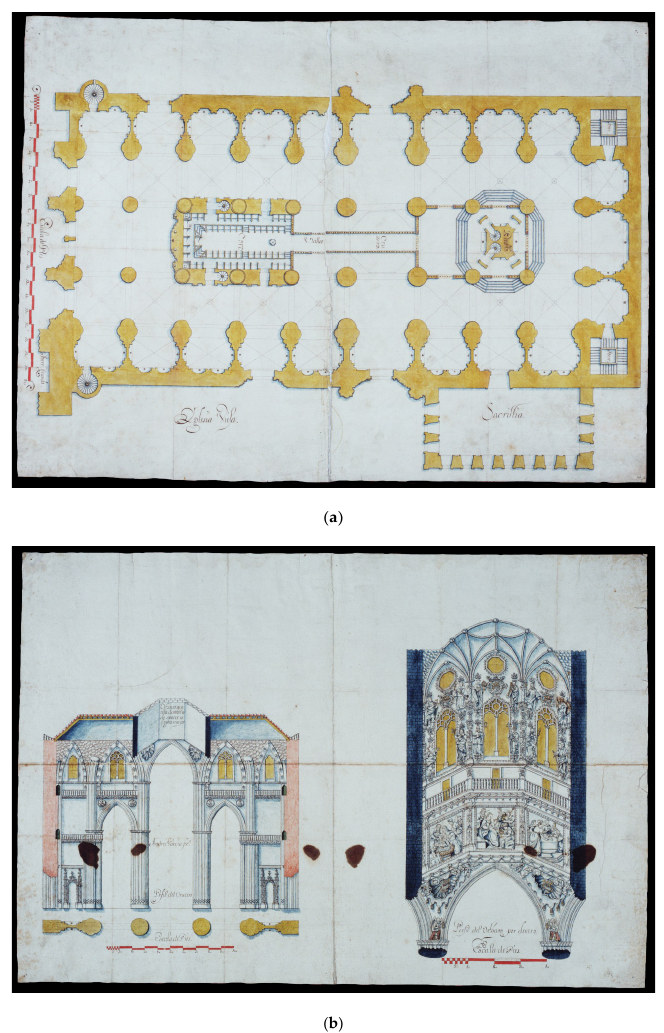
Figure 14. ( a , b ) Ground plan, double orthogonal projection of the transept, and section of the cimborrio of the new cathedral of Salamanca [Archivo Capitular del Pilar de Zaragoza (A.C.P.Z.), 6.4.1.30_1, y 6.4.1.30_2]. © Archivo Capitular del Pilar de Zaragoza.